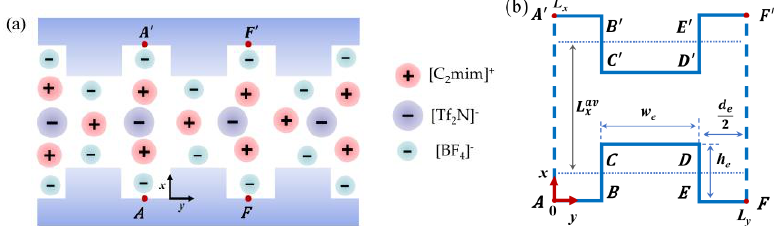
Figure 1. ( a ) A schematic of the structure of IL-ions and a rough nanopore. ( b ) A schematic of the computational domain.